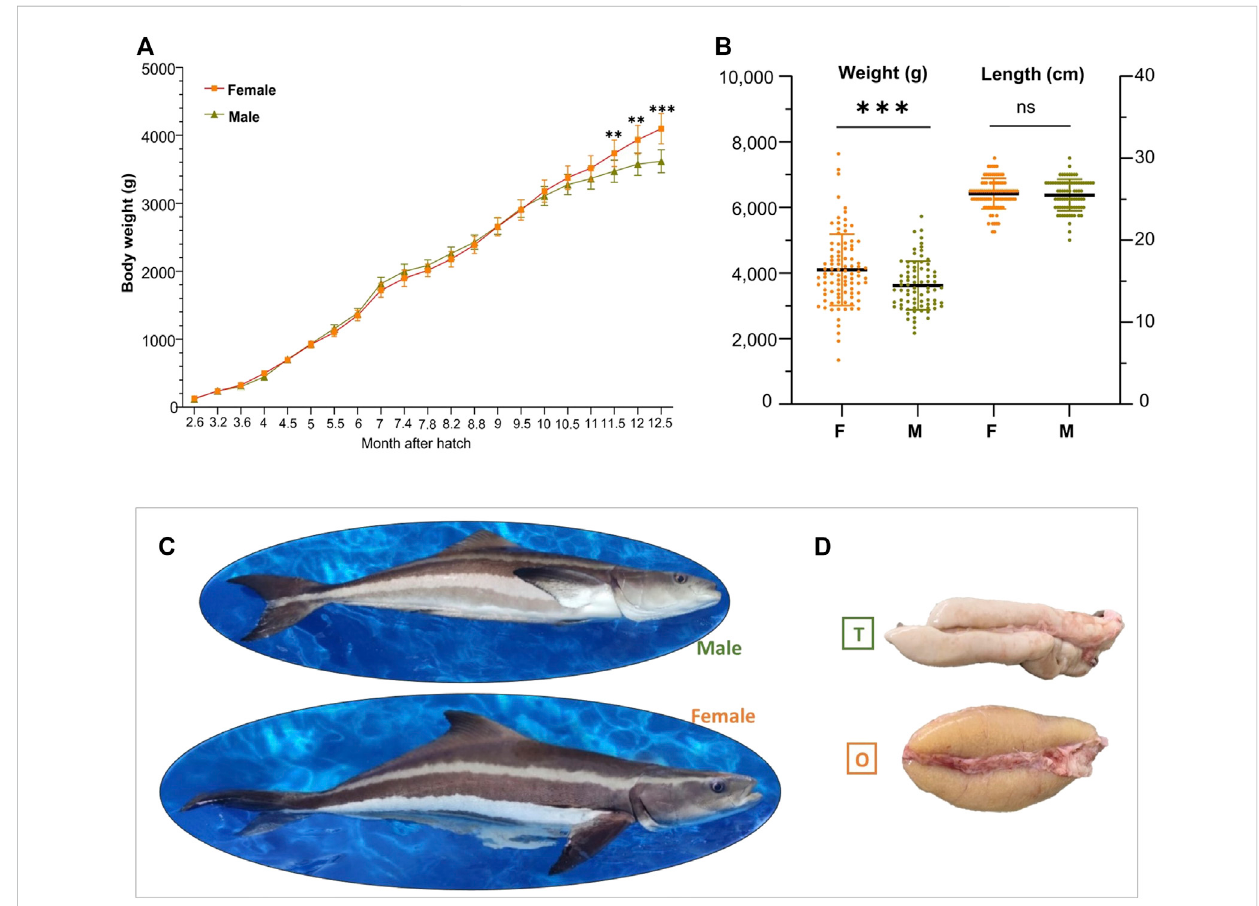
FIGURE 1 Sexual dimorphism in the growth of cobia. (A) Body weight of cobia at indicated time points after hatching (spawning date: 04/04/2018). (B) Body weight and body length of 1-year old adults ( n = 170; M_Male_77&F_Female_93). “ ** ” , p < 0.01 and “ *** ” , p < 0.001 . (C) Representative photos of 2-year old male and female cobia. (D) Photos of the cobia gonads at adult stage. T, testis; O,